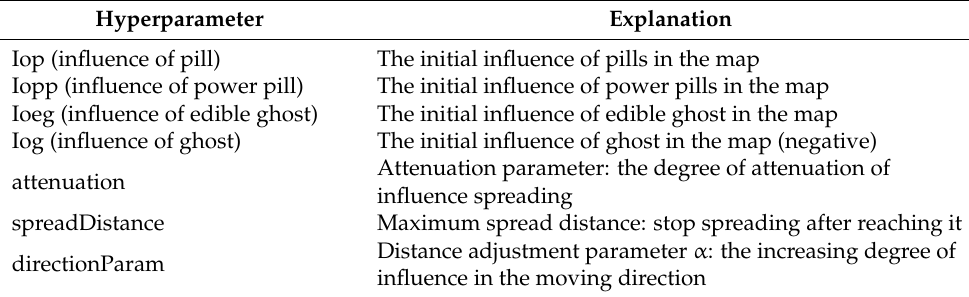
Table 1. Explanation of the hyperparameters in the influence